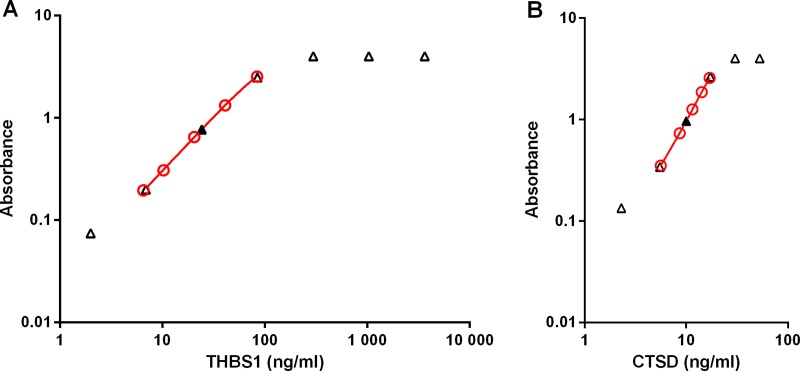
THBS1 and CTSD ELISA calibrator and sample curves.Five calibrators with different levels of THBS1 (A) and CTSD (B) were measured to generate calibration curves (red, open circles) for the determination of the concentration of THBS1 and CTSD in serum samples measured at the recommended dilution (filled triangle). Dose response of one sample representative of 3 measured at different dilutions is plotted using the concentration measured at the recommended dilution and the theoretical concentrations calculated based on the respective dilutions for the other points (open triangles).